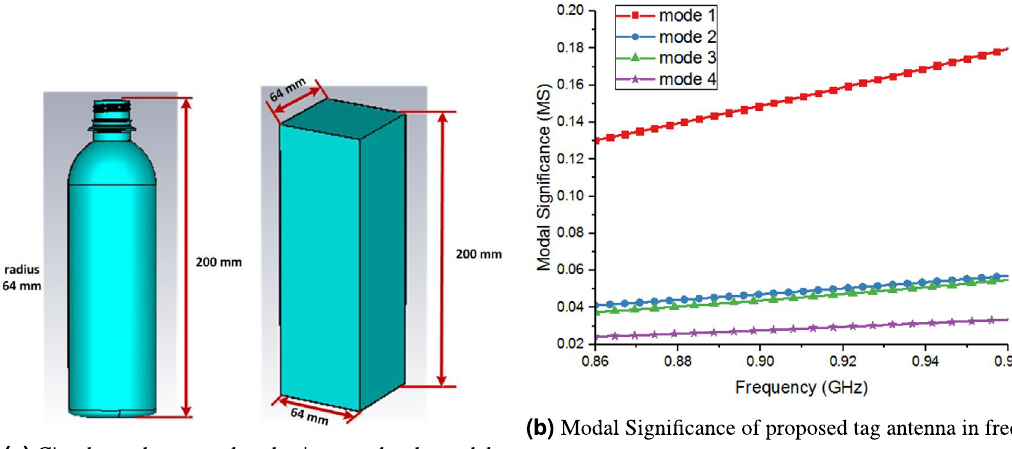
Figure 3. Water bottles models along with modal significance of proposed taken as 79.5 and 0.01, respectively. Also, the dielectric constant of water bottle and tag’s paper substrate was taken as 3.4 and 3.1 respectively. The CMA technique was used for analysis and design of proposed tag antenna.